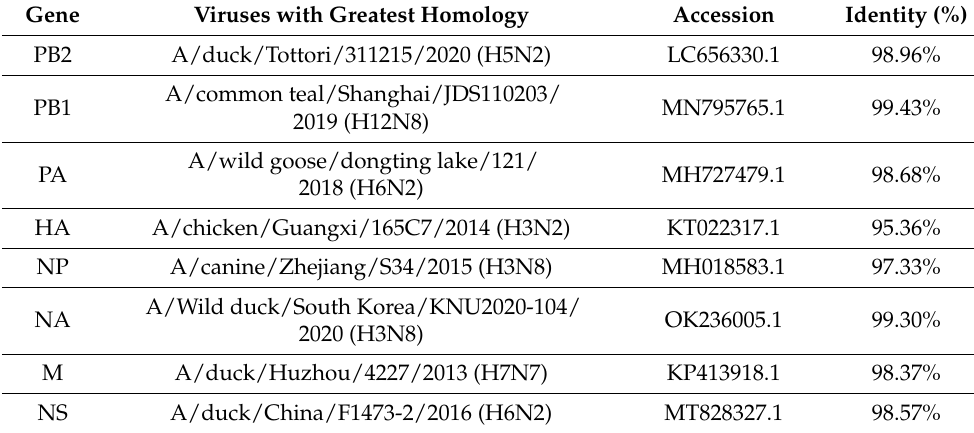
Table 1. Sequence identity of each gene between the JX 5-1 virus and the closest homologs in the GenBank